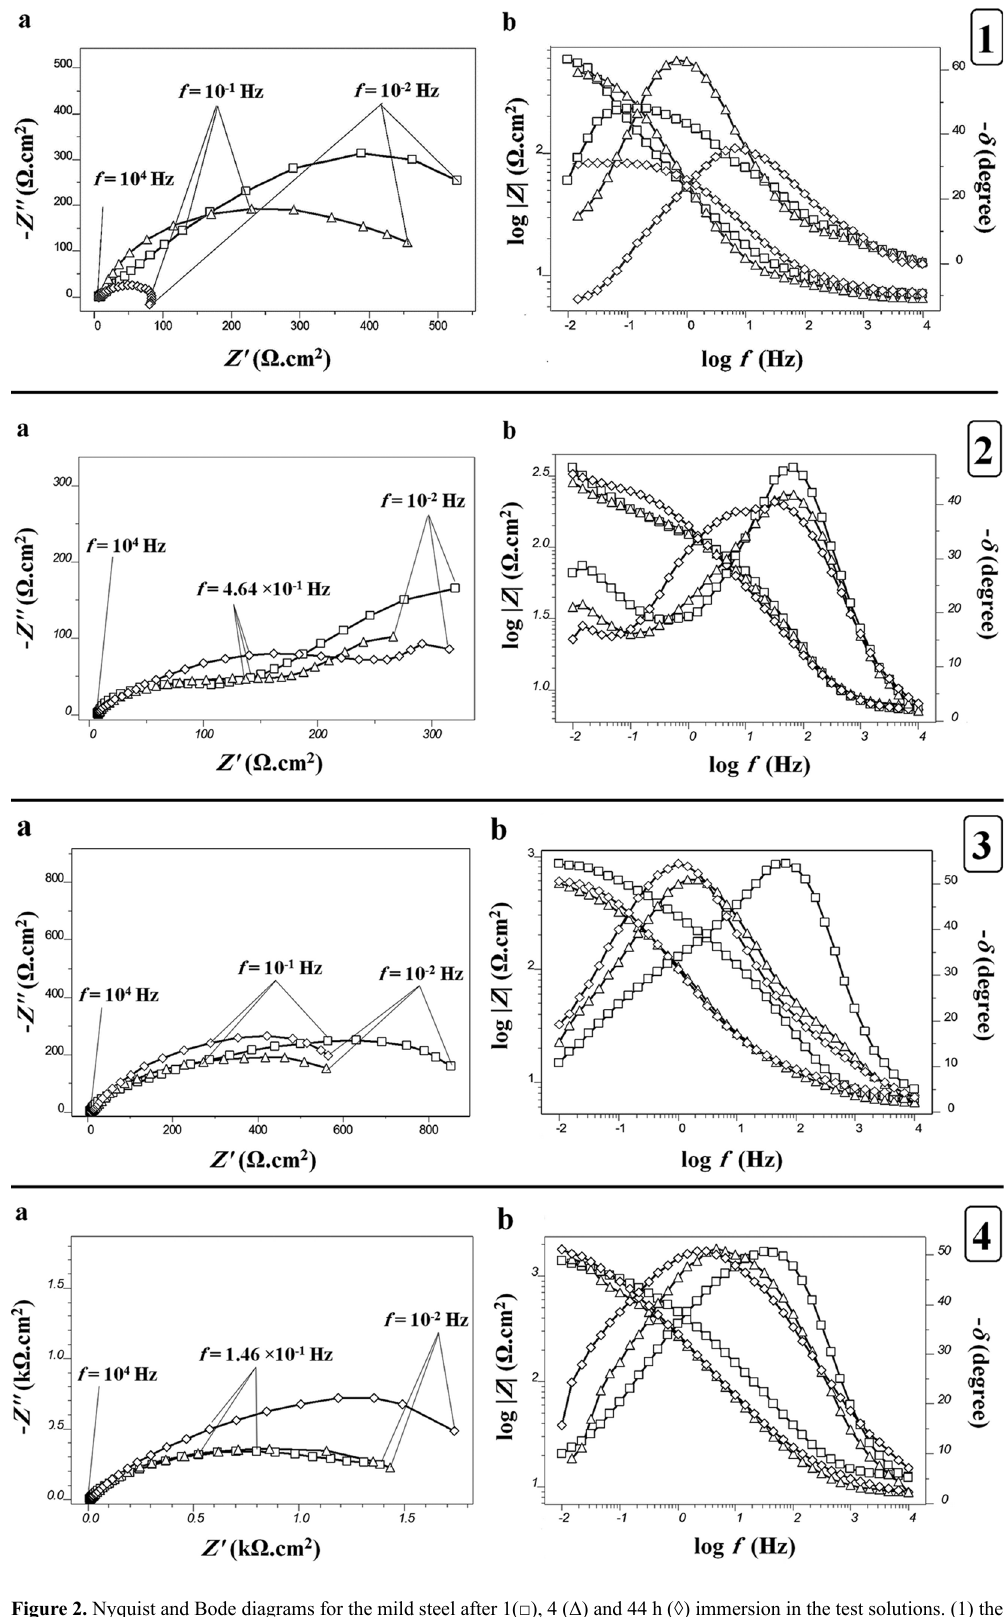
Figure 2. Nyquist and Bode diagrams for the mild steel after 1(□), 4 (Δ) and 44 h (◊) immersion in the test solutions. (1) the blank solution. (2) α-NZF containing solution. (3) β-NZF containing solution. (4) γ-NZF containing